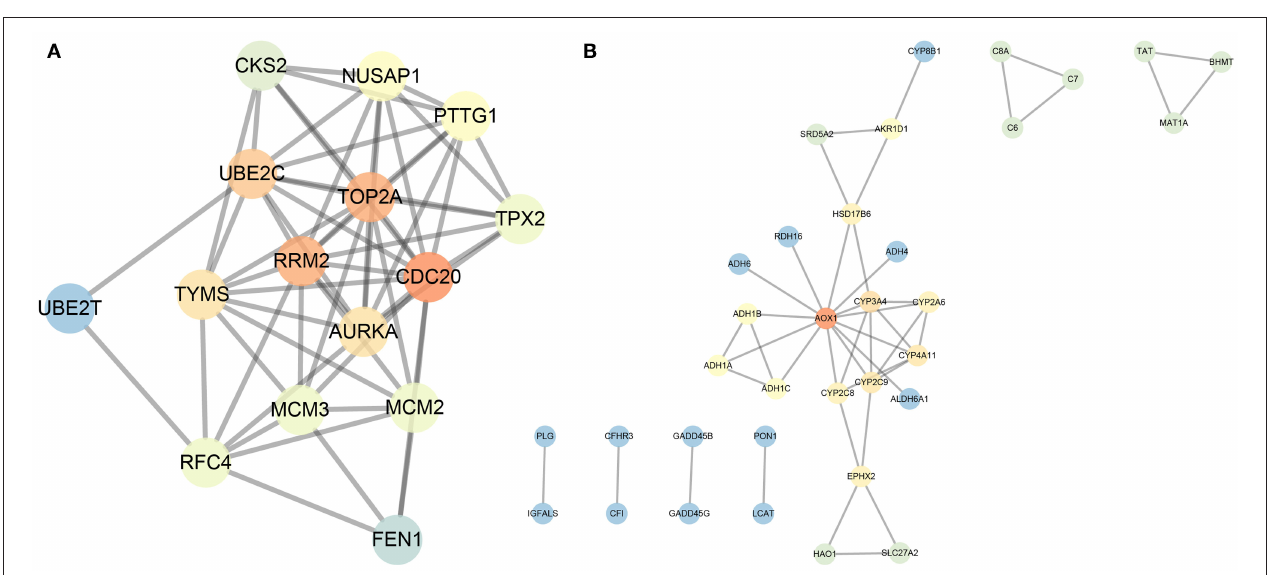
Frontiers in Medicine |